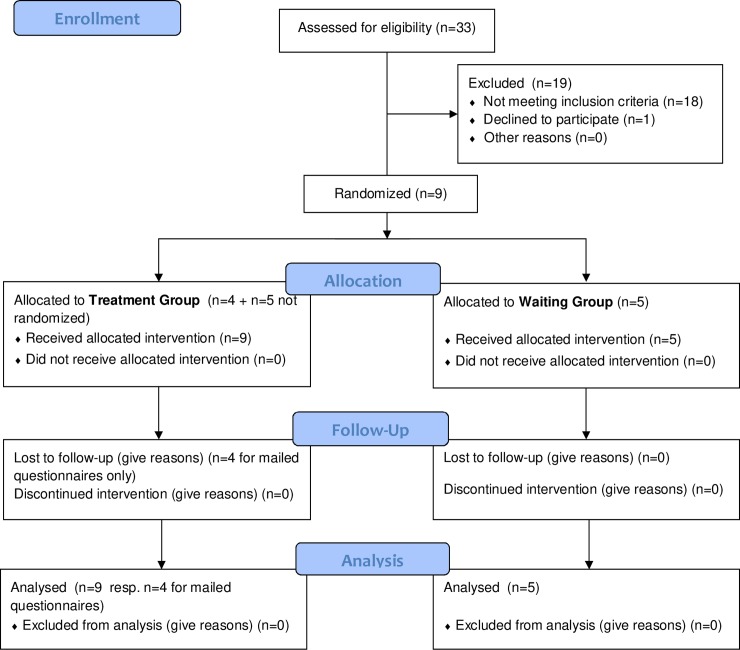
CONSORT flow chart.